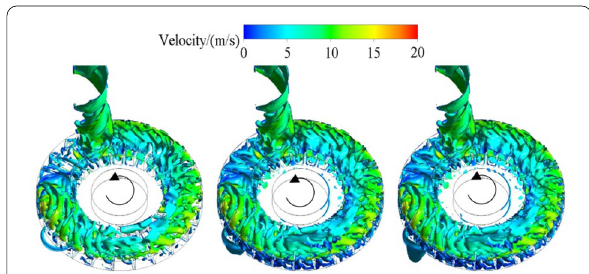
Figure 6 Vortex structures identified under different δ values ( a )